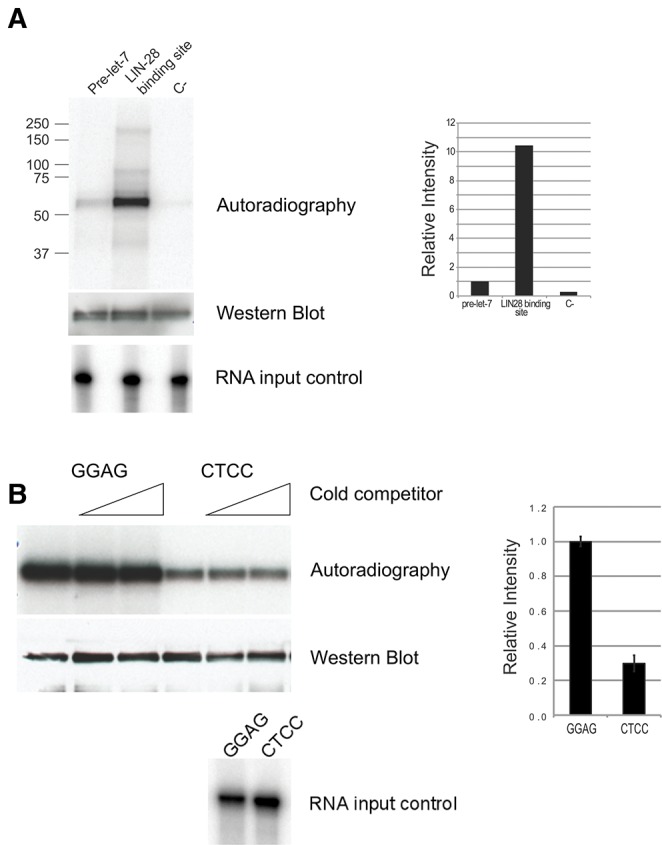
Binding of LIN-28 to pri-let-7 assessed through an in vitro UV-crosslinking assay with radiolabeled RNA. (A) Autoradiography showing LIN-28 (fused to GFP, HA, and flag, migrating in SDS-PAGE at ∼55 kDa), expressed in C. elegans larvae, immunoprecipitated and UV crosslinked to the indicated P32 body-labeled RNAs (see Materials and Methods for sequences and details). The same filter used for radiography was probed with antibody against HA to verify the presence of equal amounts of LIN-28 (“Western blot”). Labeled RNA corresponding to pre-let-7, LBS, and negative control were analyzed by TBE–Urea gel electrophoresis to verify the presence of equal amount of probe and its integrity (“RNA input control”). The panel on the right shows a quantitation of the autoradiography by Phosphoimager. (B) Interaction of LIN-28 with the LBS or a mutated version of it in which GGAG motifs are changed to CCTC. An in vitro UV-crosslinking assay as in A is shown, in which the probe was LBS containing either wild-type GGAG motifs (right three lanes) or mutated CTCC (left three lanes). The experiment was executed in triplicate for each probe. In the second and third lane of each probes, cold competitor corresponding to negative control (as in A) was also included in a 40- and 200-folds molar excess compared with the labeled probe. The same filter used for radiography was probed with antibody against HA (“Western blot”). Labeled RNA corresponding to GGAG or CTCC probes were analyzed by TBE–Urea gel electrophoresis (“RNA input control”). The panel on the right shows a quantitation of the autoradiography by Phosphoimager.